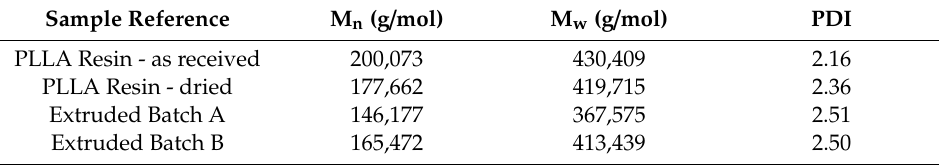
Table 2. GPC results of the PLLA resin (as received and dried) and extrusion Batches A and B.